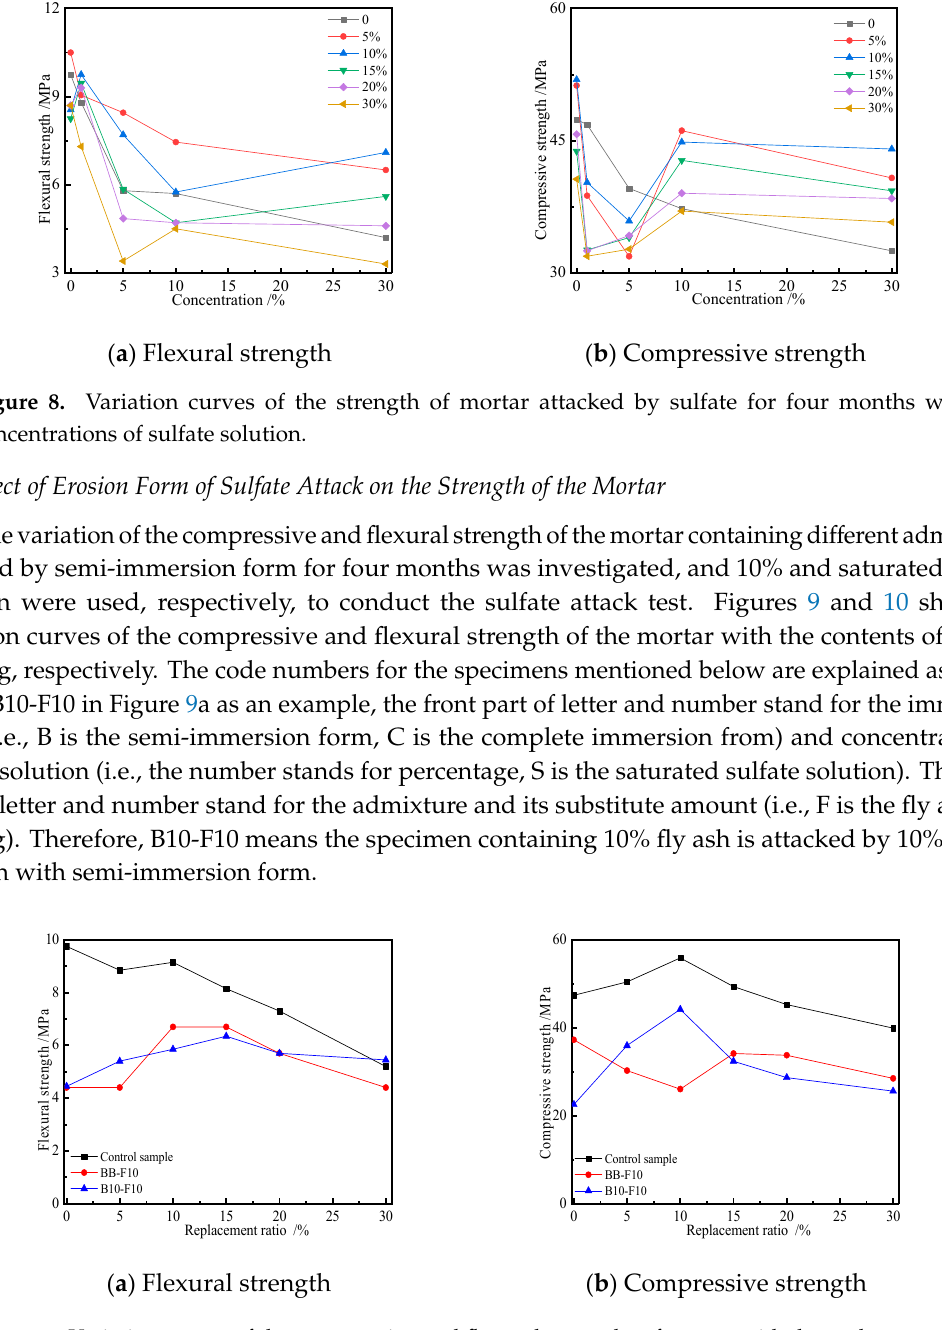
( b ) Compressive strength Figure 7. Variation curves of the strength of the mortar with slag content. As seen from Figure 7, the compressive and flexural strength of the mortar attacked by sulfate for four months first increased and then decreased with the increase of the replacement ratio, and the corresponding strength values were less than that of the control sample. The variation of the flexural strength of the mortar attacked by sulfate was more sensitive. Although the change laws of the strength of the mortar attacked by sulfate were similar, the corresponding variations of the strength were different. There exists a maximum value of the strength of the mortar with a replacement ratio ranging from 5% to 15%. The above results indicate the sulfate solution concentration has a significant effect on the variation of the mortar’s mechanical properties. In comparison with Figure 6, it can be seen that the variation of the strength of the mortar attacked by sulfate for four months was more significant and its regularity was better. This may be due to the fact that the sulfate attack plays a negative effect on the performance of the mortar. Compared with the strength variation of the mortar containing fly ash in Figure 3, the corresponding strength of the mortar containing slag was higher.